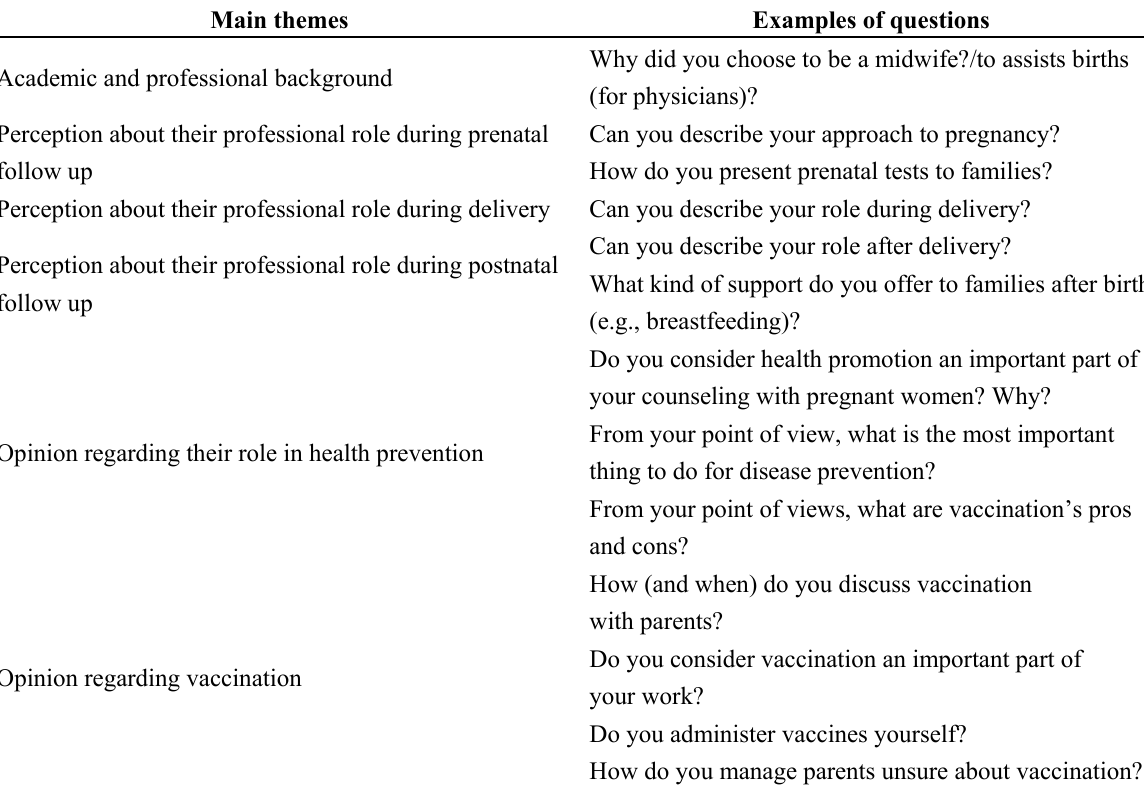
Table 1. Semi-structured guide for the interviews with physician and